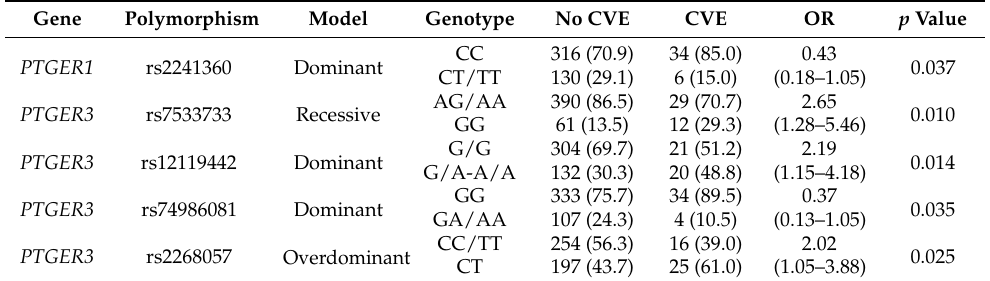
Table 5. Crude risk analysis for the occurrence of cardiovascular events in nephrosclerosis patients.